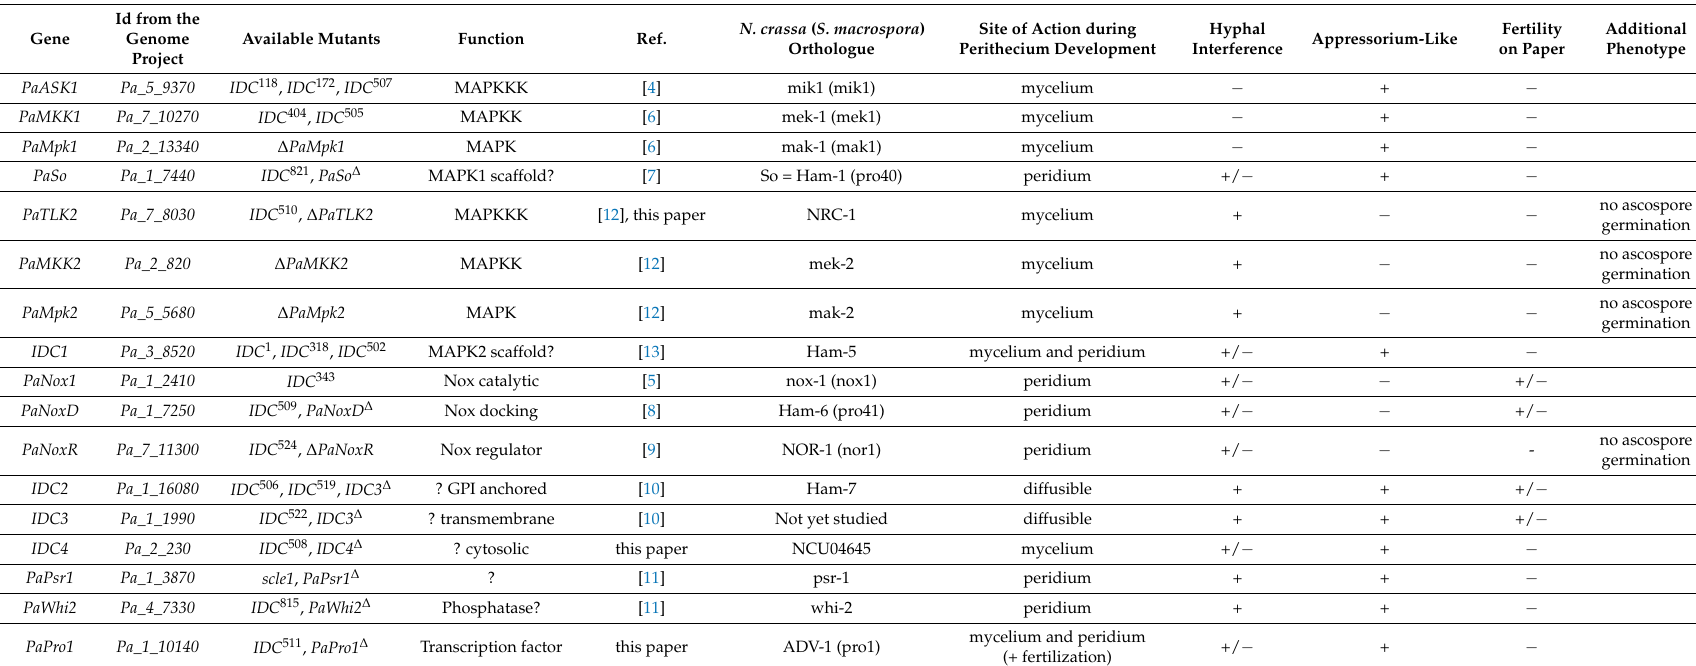
Table 2. Genes identified by the analysis of pink IDC